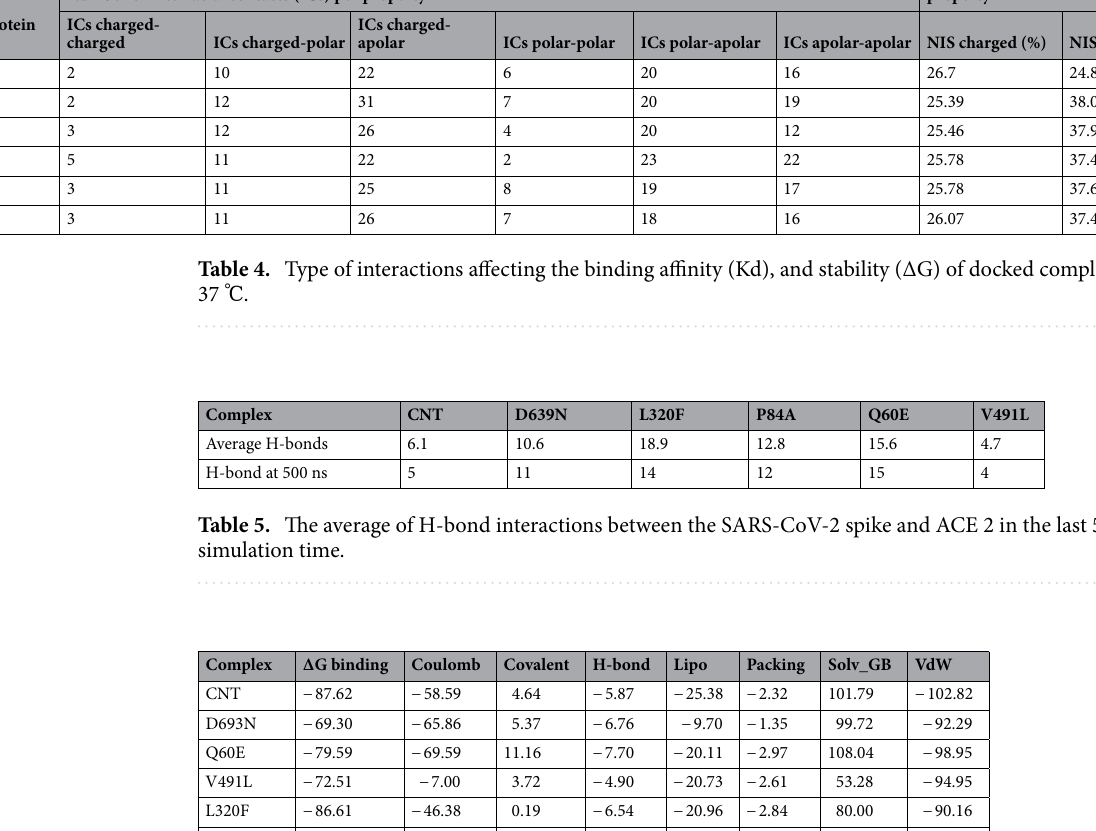
Non interacting surface (NIS) per property